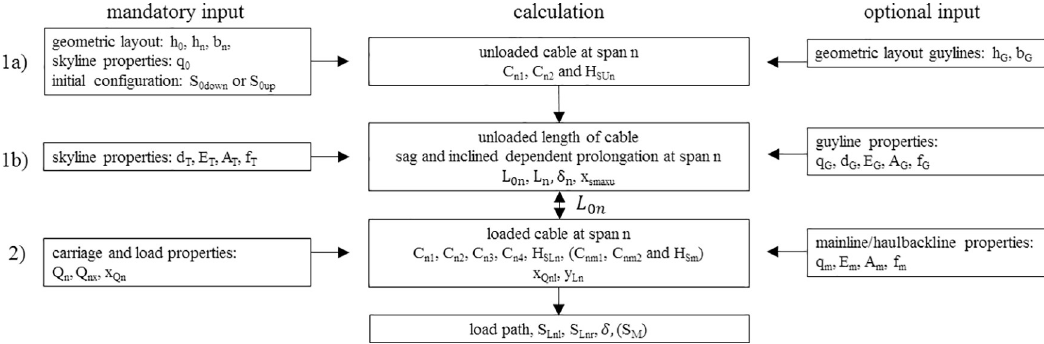
Fig 1. Calculation scheme. 1a) Calculation of the unloaded skyline span properties for all n spans. 1b) Calculation of the unloaded skyline properties. 2) Calculation of the skyline properties for a loaded cable at span